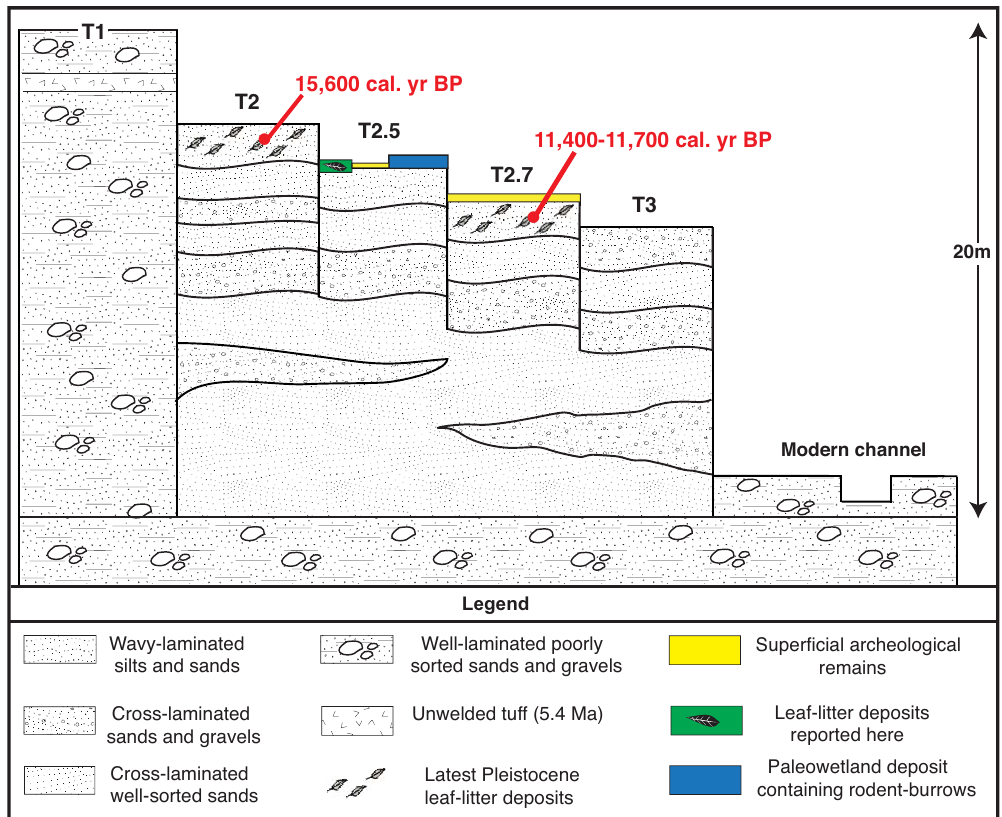
Fig. 3. A generalized stratigraphy of fluvial terraces found in Quebrada Man´ı (modified from Nester et al., 2007) showing the relationship between these units and the records reported here. Terraces are labelled in descending order (to the modern channel) as T1, T2, T2.5, T2.7, T3 and “modern”. Fluvial terrace systems T2 and T3 dissect late Miocene alluvial fan deposits (T1) at ∼ 1200m elevation, spreading beyond this point to form alluvial fans. The modern channel is inset by 1–3m at 1250m elevation and rests > 5m below T3 and continues as a confined channel for several kilometres downstream. Late Pleistocene leaf-litter deposits (ages shown in red numbers) and paleohydrological implications were reported in Nester et al.